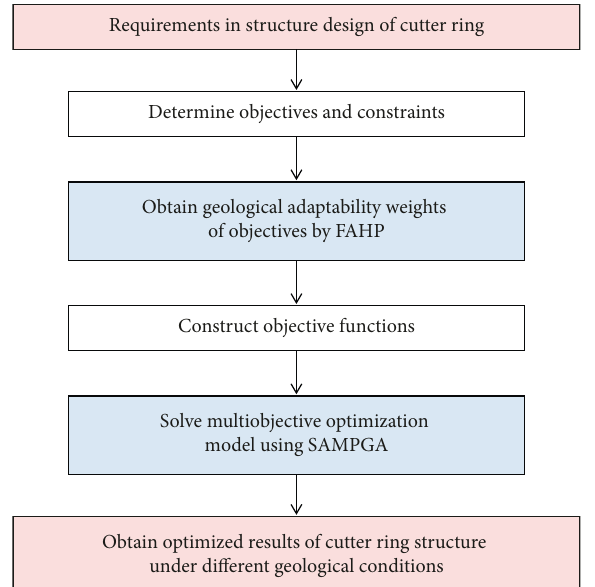
Figure 3: Flow chart of cutter ring structural design based on the proposed method.